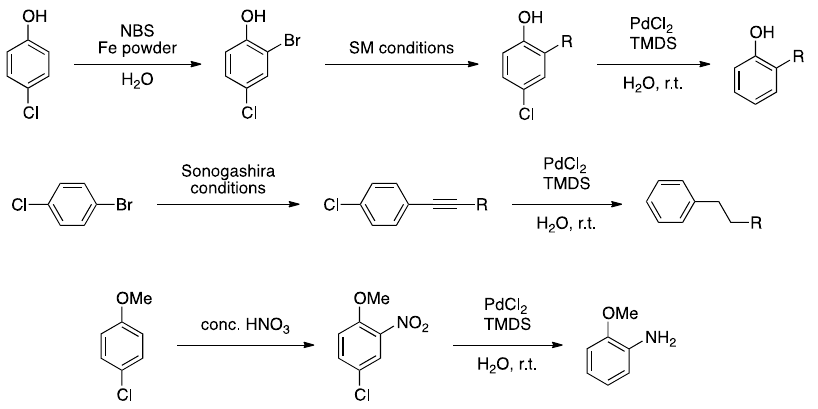
Scheme 27. One-pot cross-coupling/reduction reactions in water catalyzed by in situ generated PdNPs